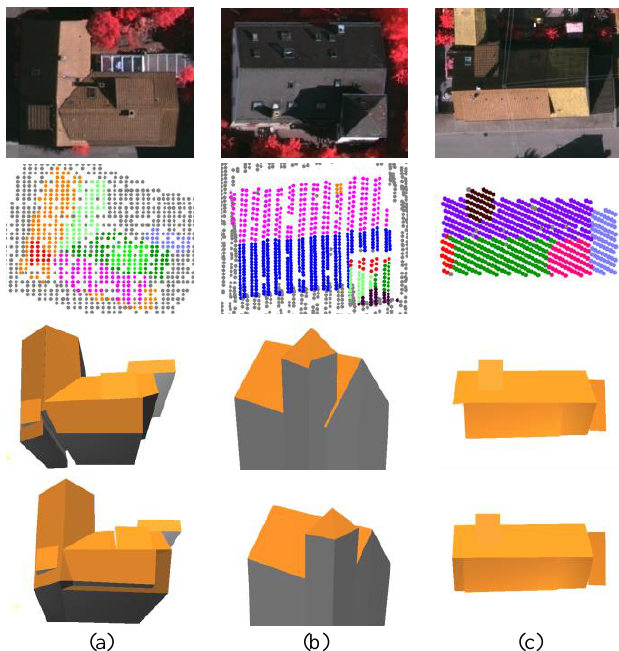
Fig .6 Improvements by methods using HRTG: Image, segmented points clouds, results use RTG and our final results are provided.